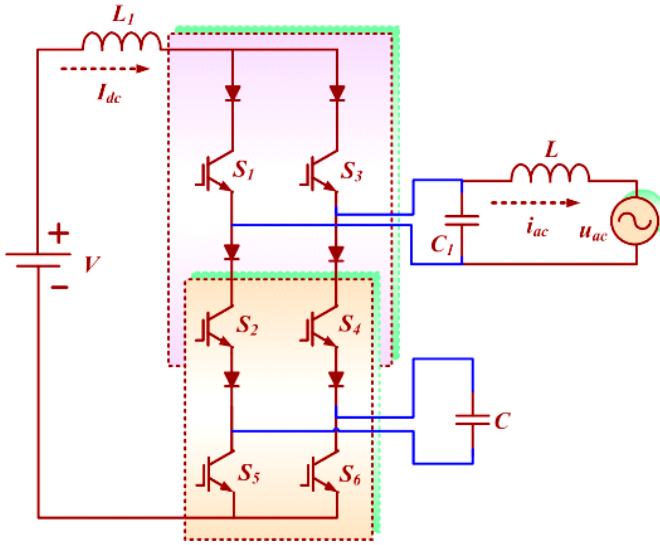
Figure 13. Power decoupling solution in [40].